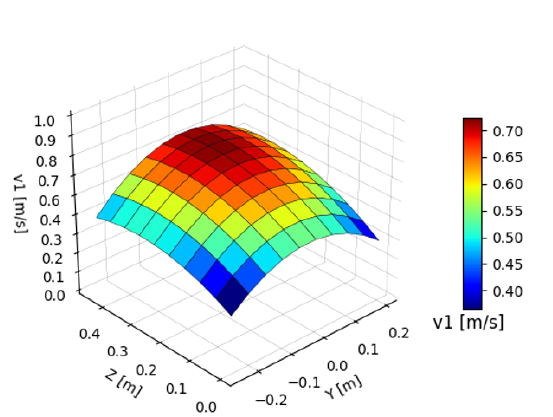
Figure 7. Measured velocity field in front of the wheel extrapolated from 5 × 5 support